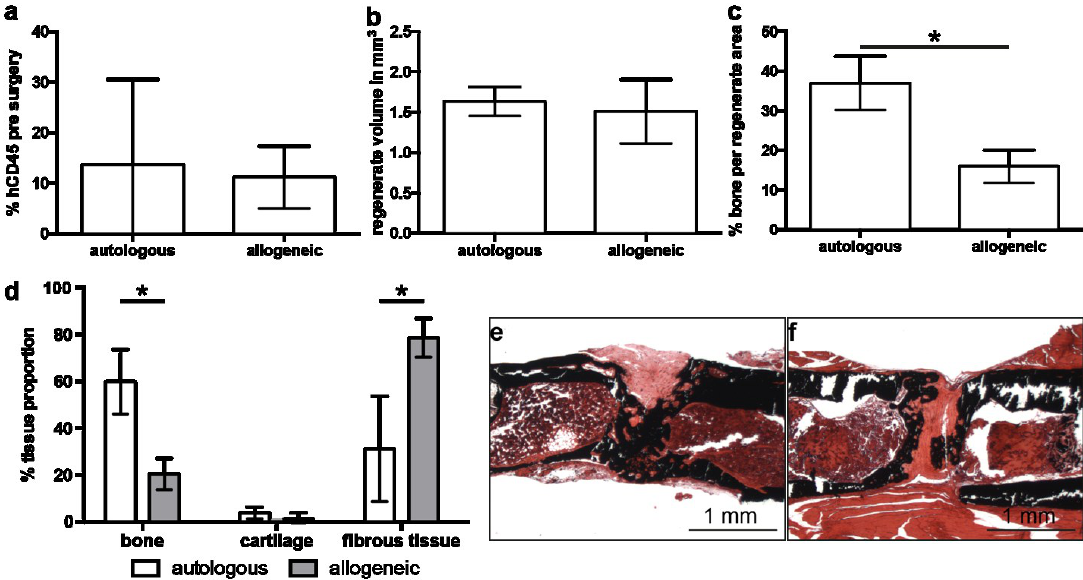
Figure 2. Analysis of defect regeneration in mice treated with autologous or allogeneic human mesenchymal stem cells (hMSC). ( a ) Percentage of human CD45-positive cells in the blood of humanized mice pre-surgery analyzed by flow cytometry. ( b ) Volume of the regenerate and ( c ) bone fraction in the regenerate assessed by micro-computed tomography on day 35 after surgery. ( d ) Analysis of the regenerate composition by histomorphometry on day 35. ( e , f ) Representative von Kossa-stained sections through the regenerate area of mice treated with autologous ( e ) and allogeneic ( f ) hMSC. The data are presented as the mean ± SD, * p ≤ 0.05. In ( a ) autologous n = 6, allogeneic n = 9. In ( b – d ) autologous n = 4, allogeneic n = 8.